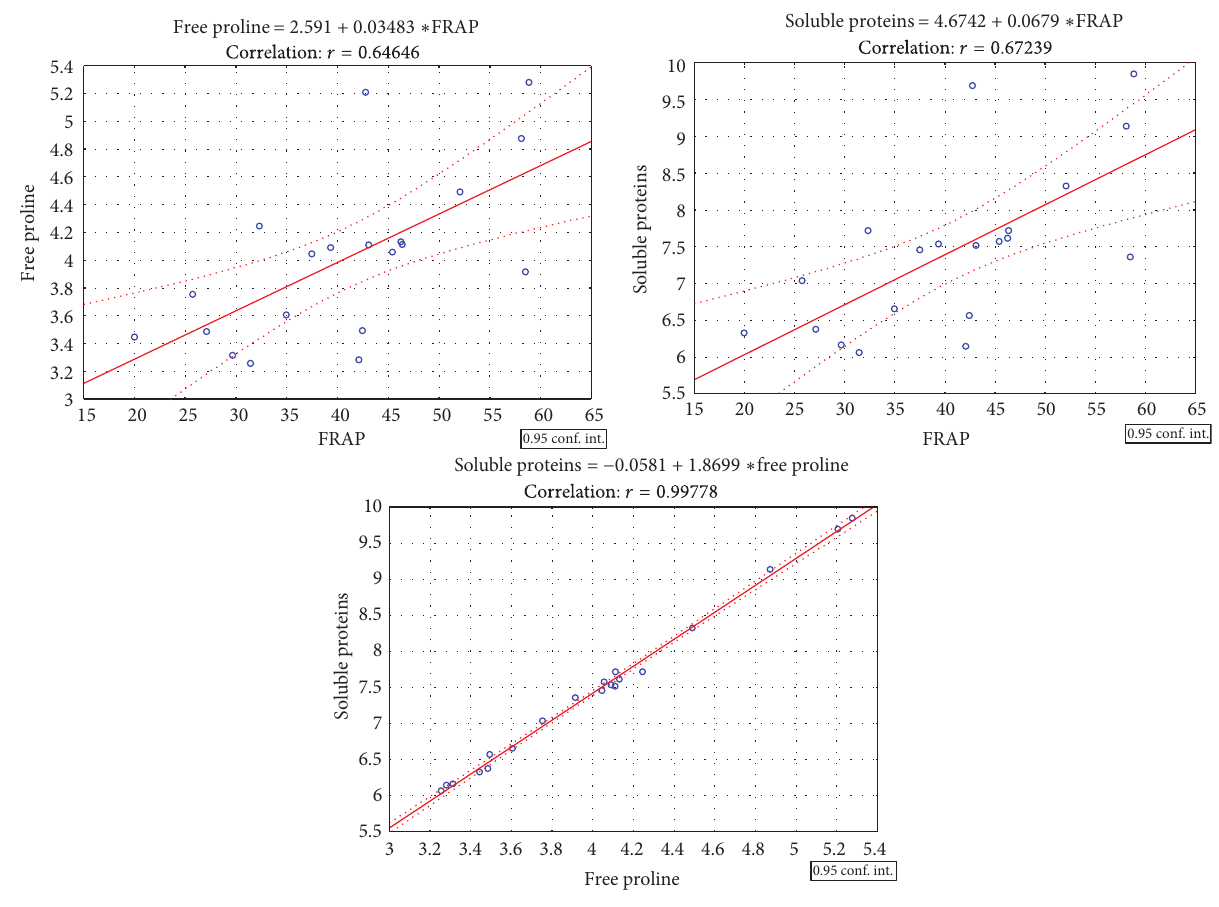
F 2: Signi�cant and positive correlations between different parameters (free proline, FRAP, and soluble proteins) in beech provenances in meadow Debeli